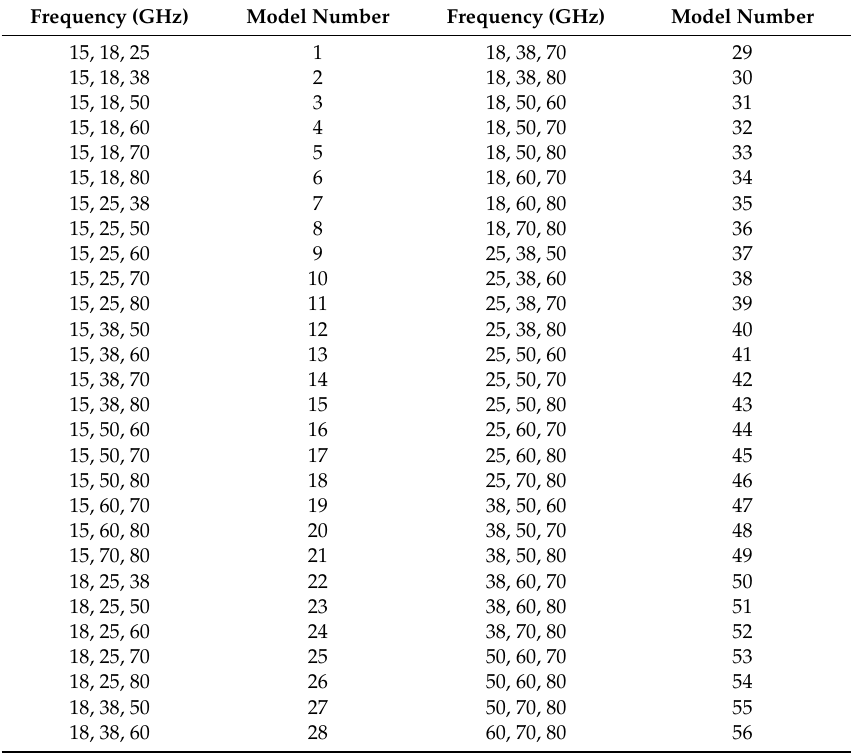
Table 4. Model numbers of tri-frequency